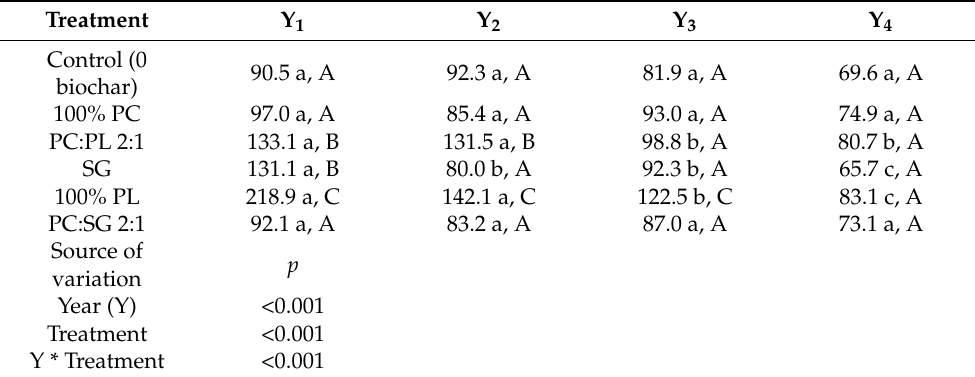
Table 8. Annual corn stover potassium (K) uptake (kg ha − 1 ) after treatment with designer biochars (means from n = 4; Y = year; PC = pine chip, PL = poultry litter; SG = switchgrass compost).